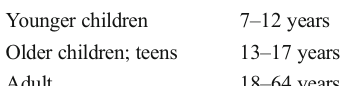
Table 1 Categorisation of age structures of vulnerable road used in